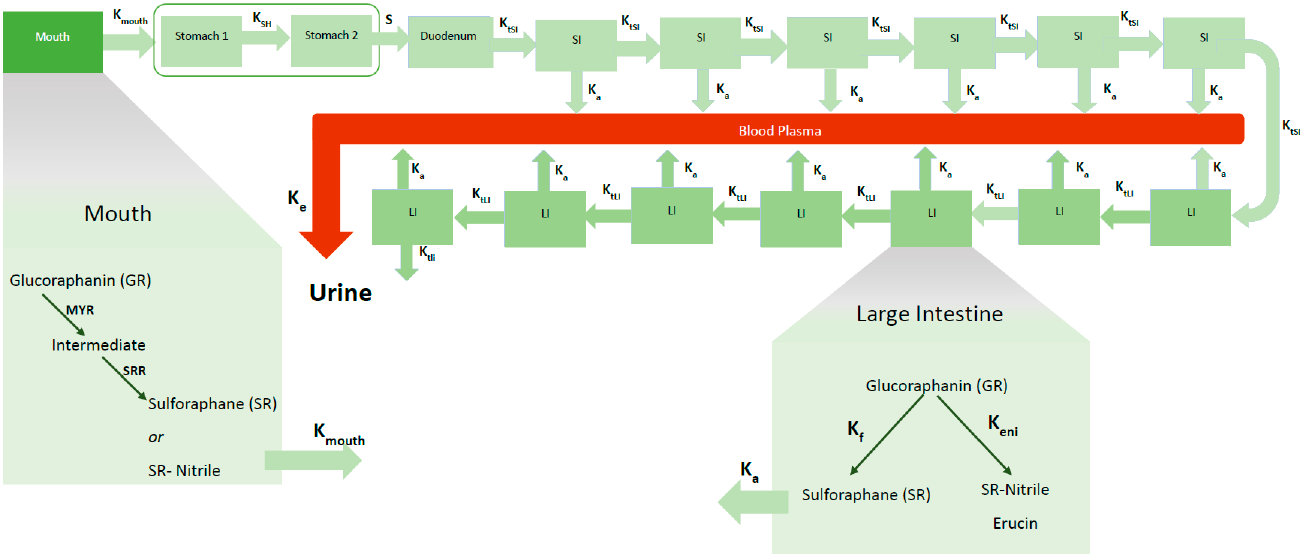
Figure 2. Schematic diagram of model with one mouth compartment, two stomach compartments, seven small intestine (SI) compartments and seven large intestine (LI) compartments, and one blood compartment. The conversion of glucoraphanin (GR) to sulforaphane (SR) and SR-nitrile and erucin in the mouth and large intestine is depicted. Shown are the transit rate constants between the mouth and stomach (K mouth ), between the two stomach compartments (K SH ), between the stomach and duodenum (S), between the small intestines (K tSI ), between the large intestines (K tLI ). The absorption of SR from the SI and LI into the blood is represented by the absorption rate constant (K a ). Elimination of SR and SR-conjugates from the blood to urine is represented by the rate constant, K e . During mastication, GR is converted to an intermediate by myrosinase (MYR) and the subsequently converted to SR or SR-nitrile based on a conversion ratio (SRR). The gut microbial conversion of GR to SR and SR-nitrile/erucin is represented by the rate constants K f and K eni , respectively.